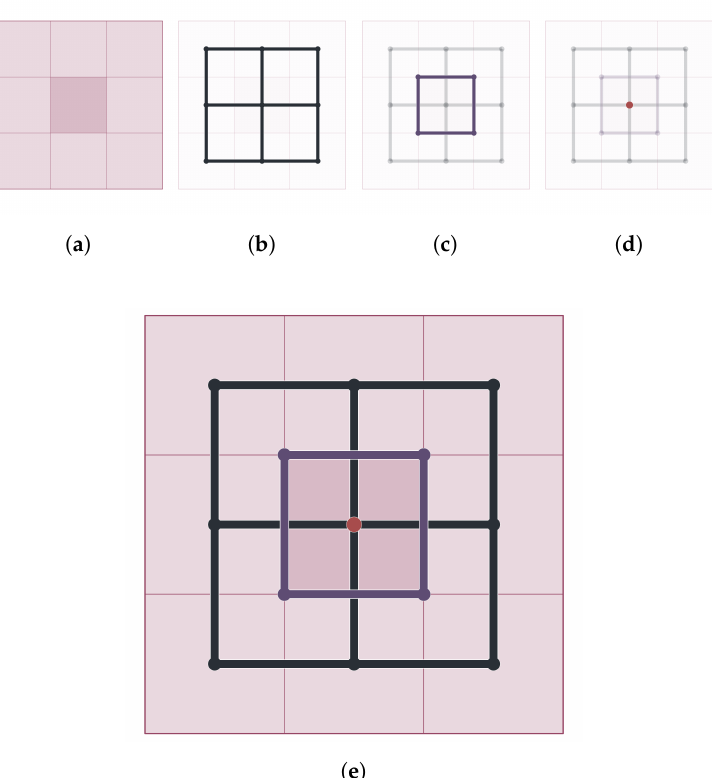
Figure 4. Successive weak duals of planar graphs. From each block’s parcels, we can construct successive weak duals of a planar graph until the resulting structure forms a trivial network (a tree). The number of weak dual operations required to reach a tree is termed the k -index for the block. Two blocks with the same k -index have the same level of infrastructure access for their enclosed buildings, regardless of block shape. ( a ) Once the parcels are generated for a block, the parcel polygons are used as the faces of a planar graph ( S 0 ). Note that the central parcel, shaded darker, has no access to the surrounding road network. ( b ) S 1 in black. ( c ) S 2 in purple. ( d ) S 3 in red, a trivial 1-node graph, indicating k = 3. ( e ) Superimposed weak dual sequence for the original